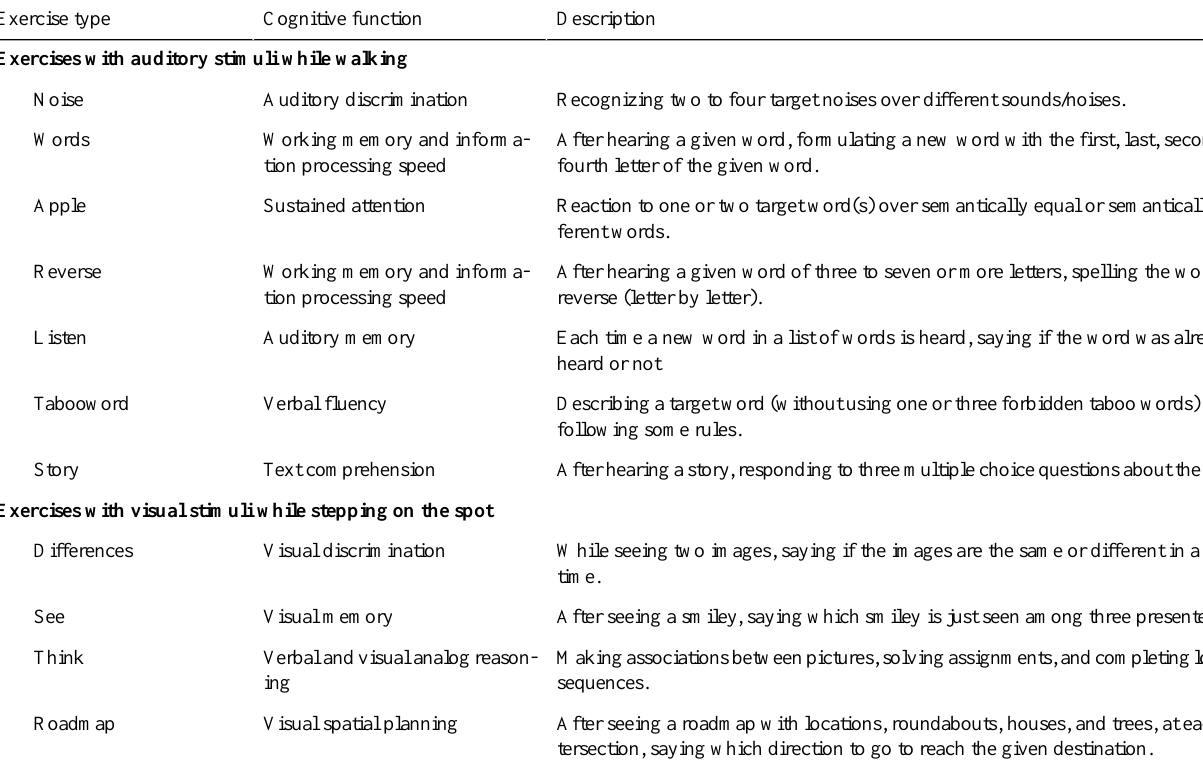
Table 1. Cognitive exercises implemented in CMI-APP.